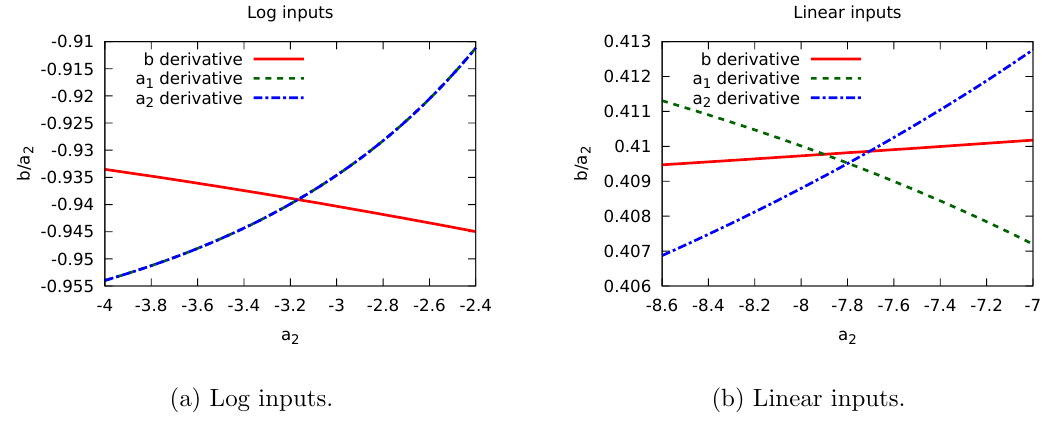
1 = 0, plotted as points in the